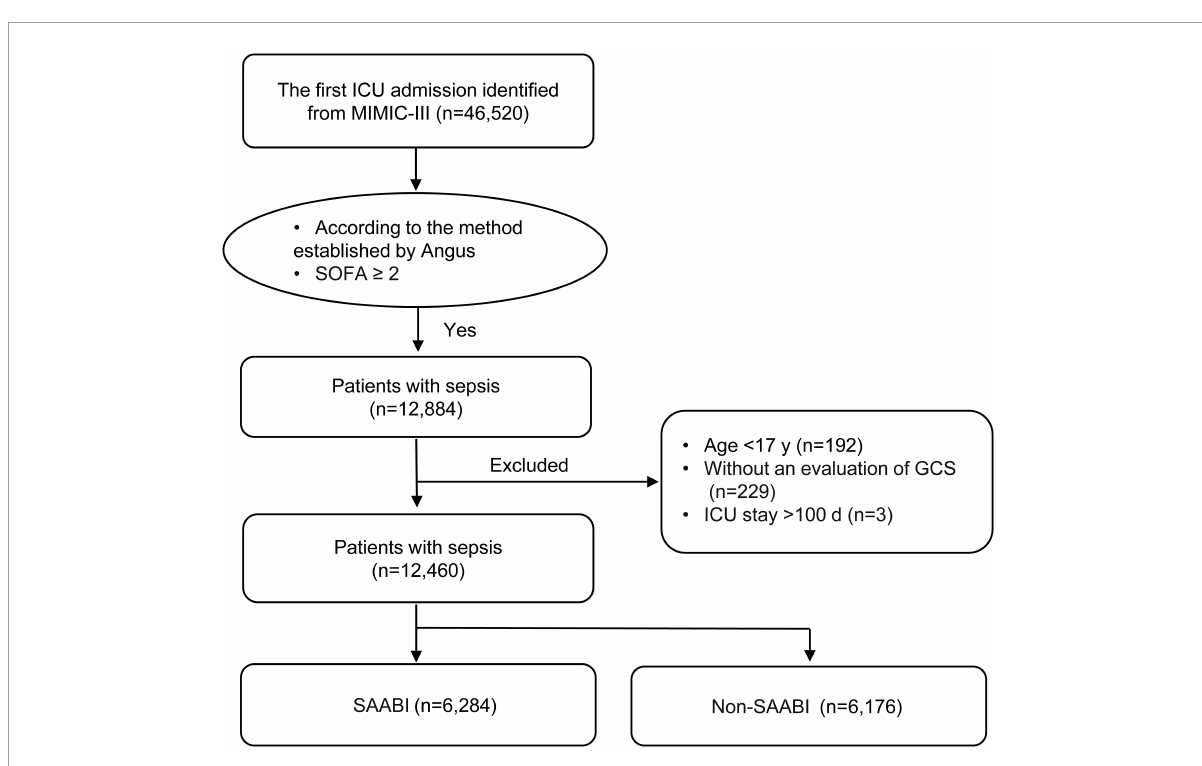
FIGURE2 Flowchart of patient screening and selection. ICU, intensive care unit; MIMIC-III, Medical Information Mart for Intensive Care III; SOFA, sequential organ failure assessment; GCS, Glasgow Coma Scale; SAABI, sepsis-associated acute brain injury.